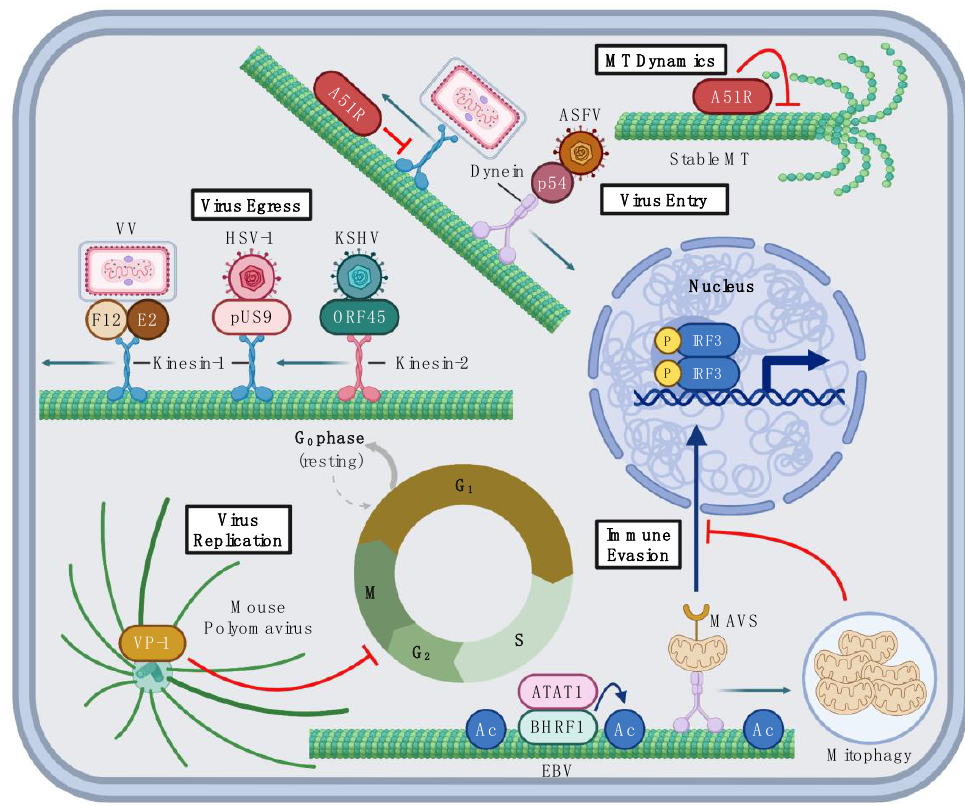
Figure 2. DNA virus interactions with MTs. Examples of how DNA viruses interact with, and manipulate, the MT network. African swine fever virus (ASFV) enters the cell and moves towards perinuclear replication sites by engaging dynein motors through its p54 MAP. Vaccinia virus (VV), herpes simplex virus 1 (HSV-1), and Kaposi sarcoma-associated herpesvirus (KSHV)-encoded MAPs associate with kinesins to facilitate virion egress. VV encodes the viral MAP A51R, that directly binds to, and stabilizes, MTs, as well as blocks kinesin-1 movement on MTs. The mouse polyomavirus VP-1 MAP binds to the mitotic spindle to prevent cell division during infection. Epstein–Barr virus (EBV) evades immune response by hyperacetylating MTs through recruitment of the ATAT1 acetyltransferase using its BHRF1 MAP, which leads to stable MT track formation, and transport of mitochondria to perinuclear sites of mitophagy. This blocks mitochondria-dependent MAVS signaling to IRF3, thereby inhibiting activation of the IFN response. Figure was created using Biorender.com (accessed on 3 May 2022).